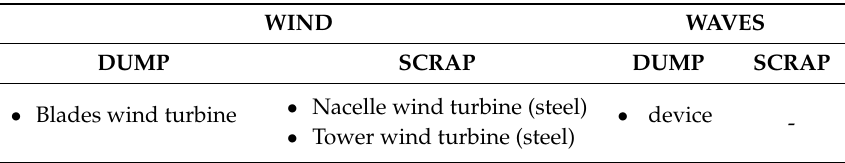
Table 2. Use of the components of the device once they were removed.